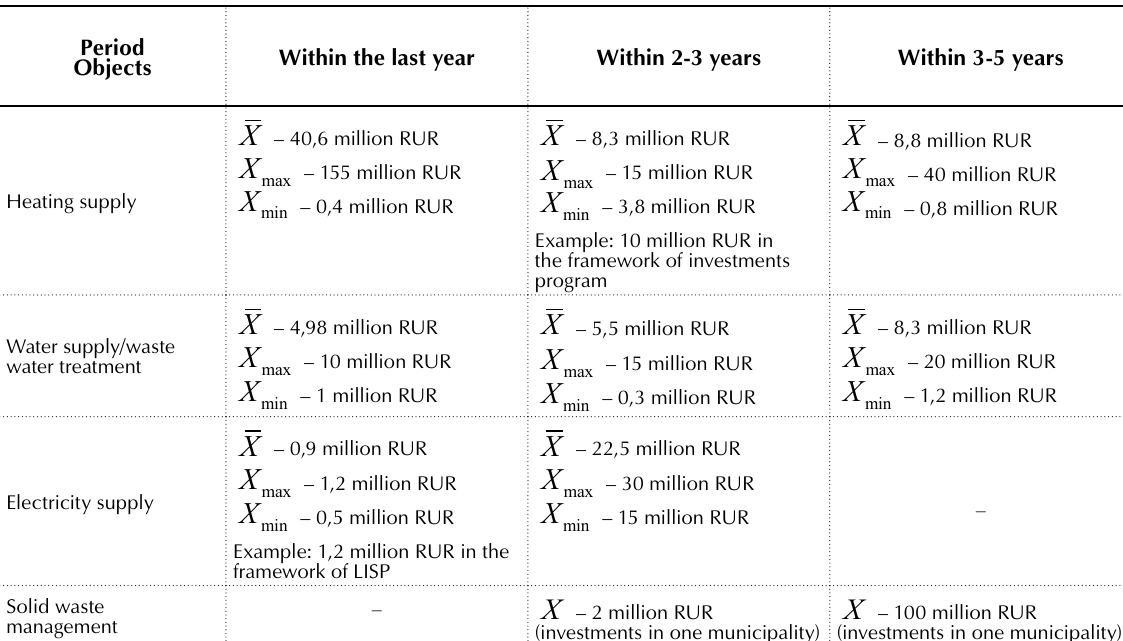
Table 3. The volume of investments per municipality in the Tver